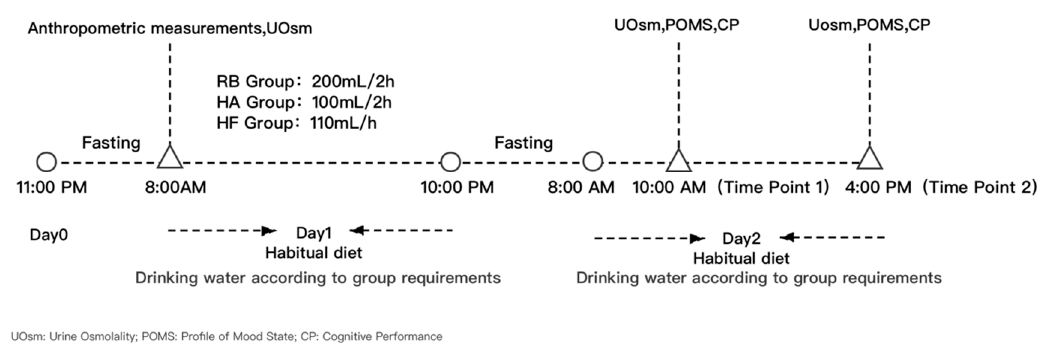
Figure 1. The study procedure.